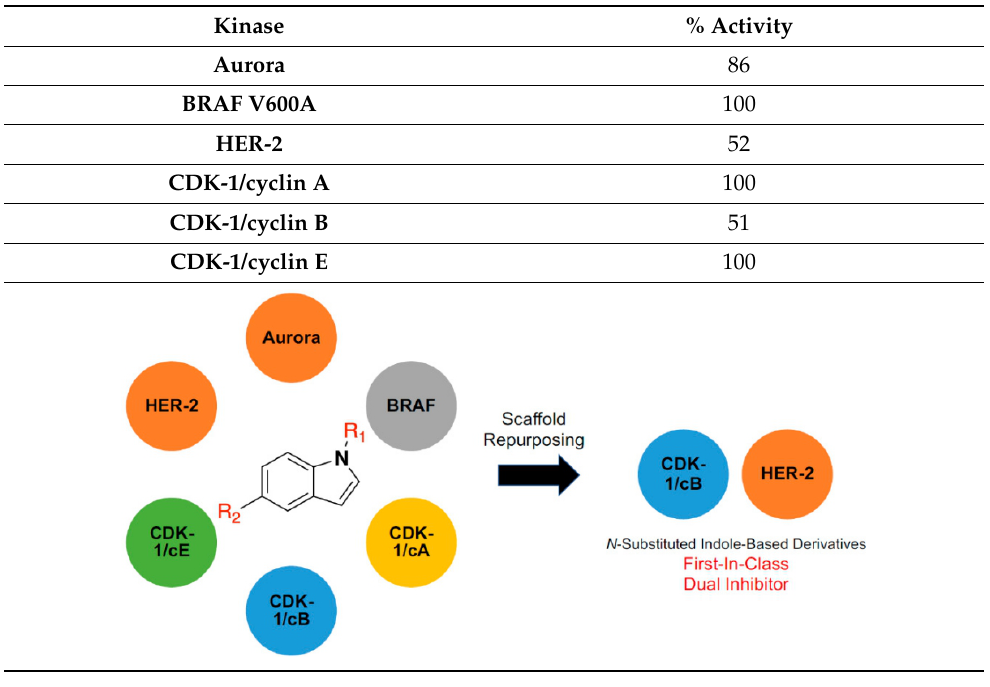
Table 3. Kinase activity (%) of 6 kinase panel with compound 15l